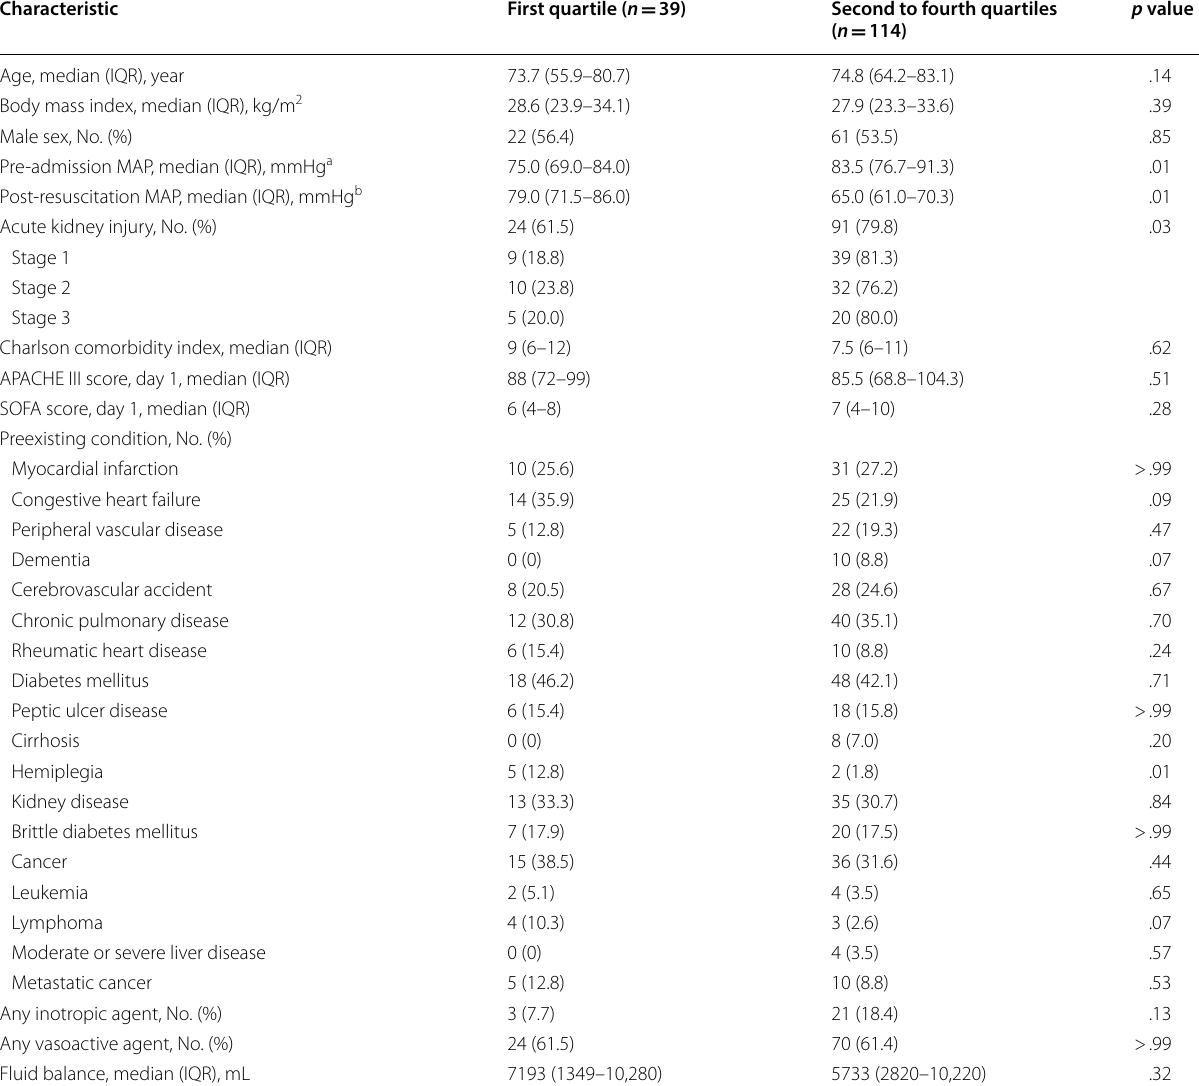
Table 5 Comparison of patients with hypertension in quartile 1 versus quartiles 2–4 of delta mean arterial pressure ( n =